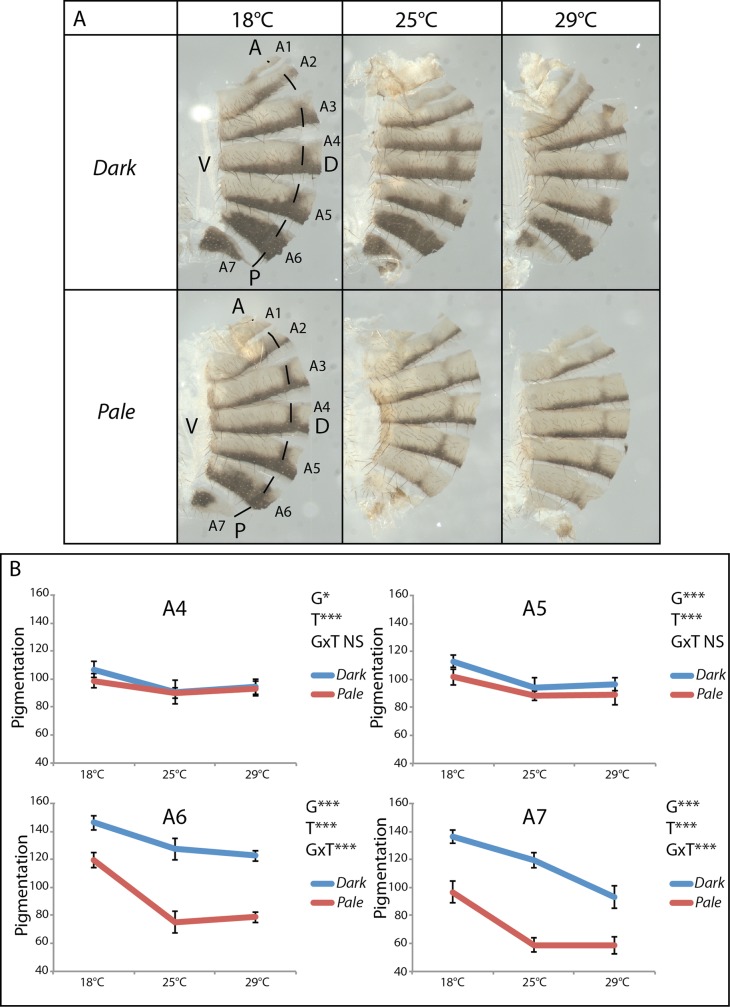
The Dark and Pale females differ in abdominal pigmentation intensity and plasticity.A: Abdominal cuticles of females from the Dark (up) and the Pale (bottom) lines grown at 18°C, 25°C or 29°C. Cuticles were cut just beyond the dorsal midline (dashed line). Hemi-abdomens are shown. Abdominal tergites A1 to A7 are indicated. A: anterior; P: posterior; V: ventral; D: dorsal. B: Reaction norms of pigmentation as a function of temperature in hemi-tergites A4, A5, A6 and A7 for the Dark (blue) and the Pale (red) lines. Error bars are standard deviations (n = 10 per genotype and per temperature). Significant effects revealed by two-way ANOVA are indicated: G = effect of the genotype, T = effect of the temperature, GxT = effect of the interaction between the genotype and the temperature. *: 0.01<p<0.05; ***: p<0.001; NS: non significant.